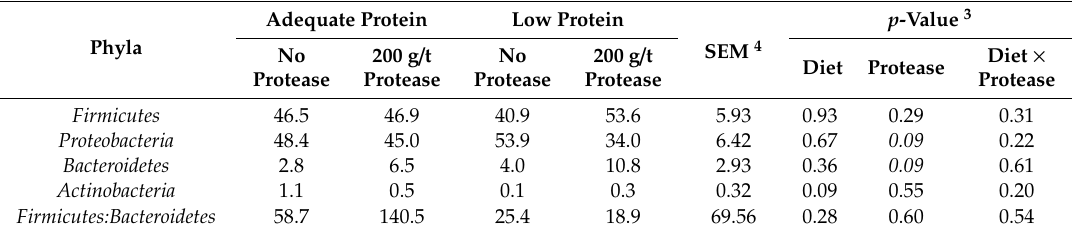
Table 5. Effect of diet 1 and protease on the relative abundance of the main bacterial phyla 2 .